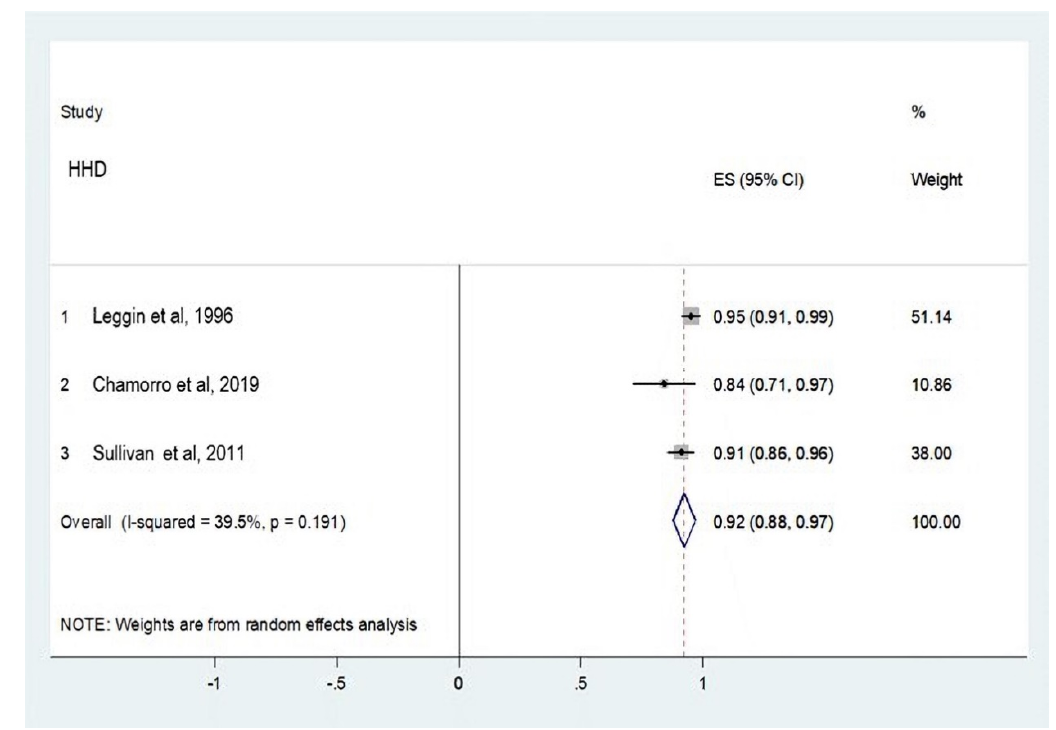
Figure 5. Meta-analysis of concurrent validity for shoulder external rotator strength assessment .